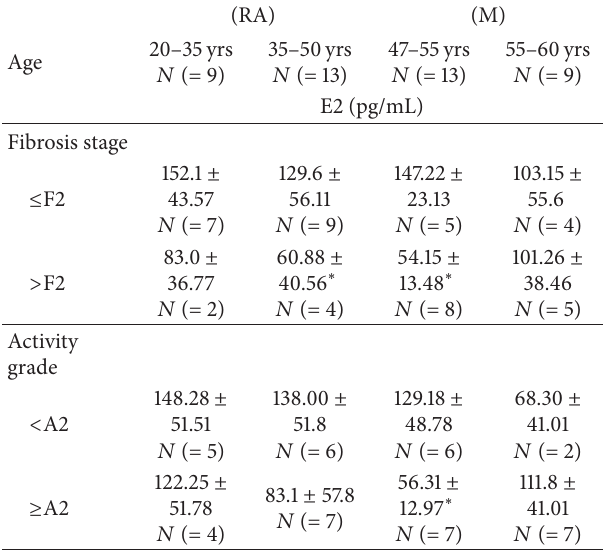
Table 7: The relation between virological response and estradiol level in reproductive aged and menopausal